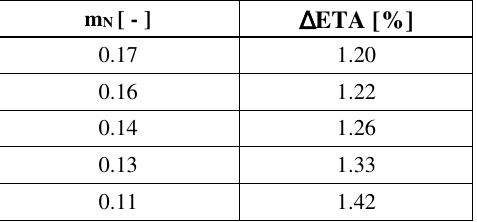
Table 1. Increase of the efficiency for Ma 2u = 0.9 .